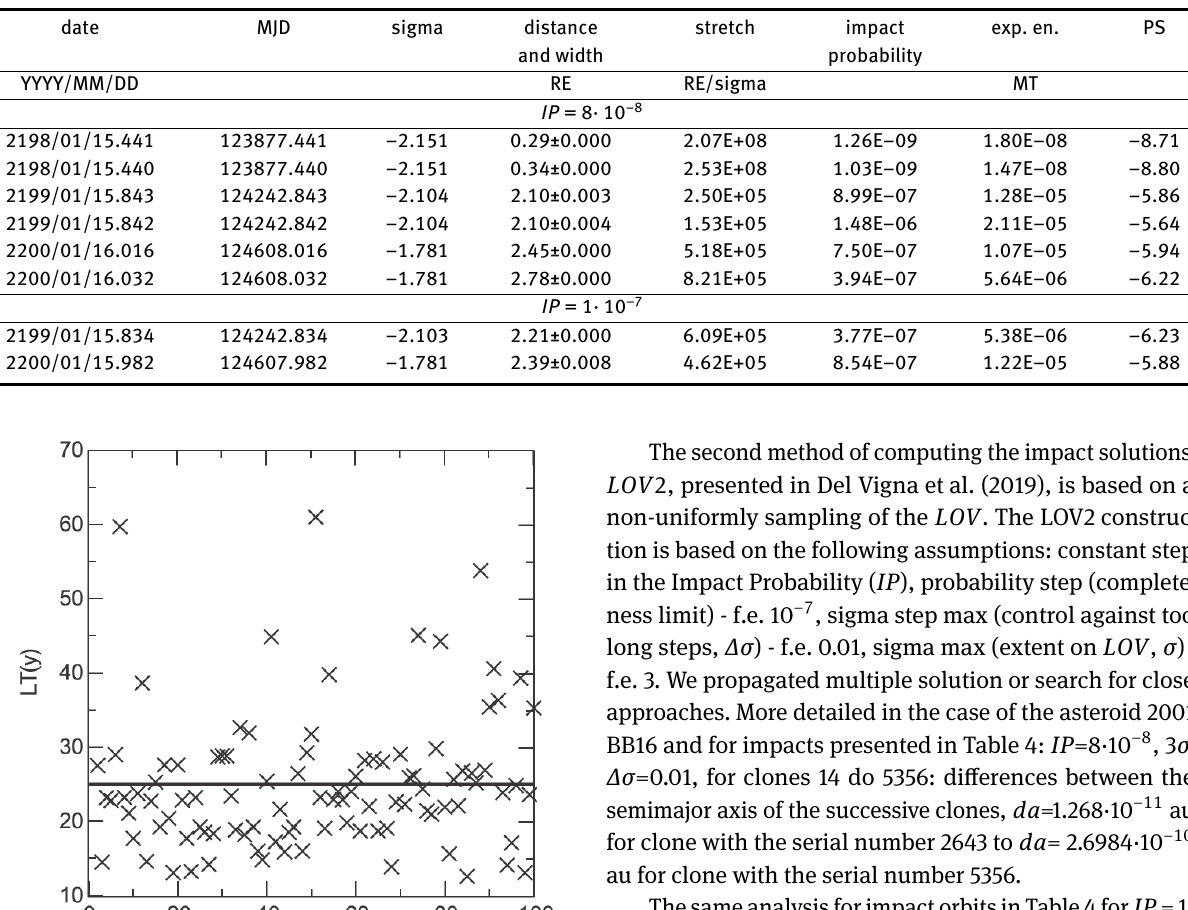
Table 4. The asteroid 2001BB16. The LOV 2 method. The dependence of computed impact risk on IP parameter for computed non- asteroids are added.